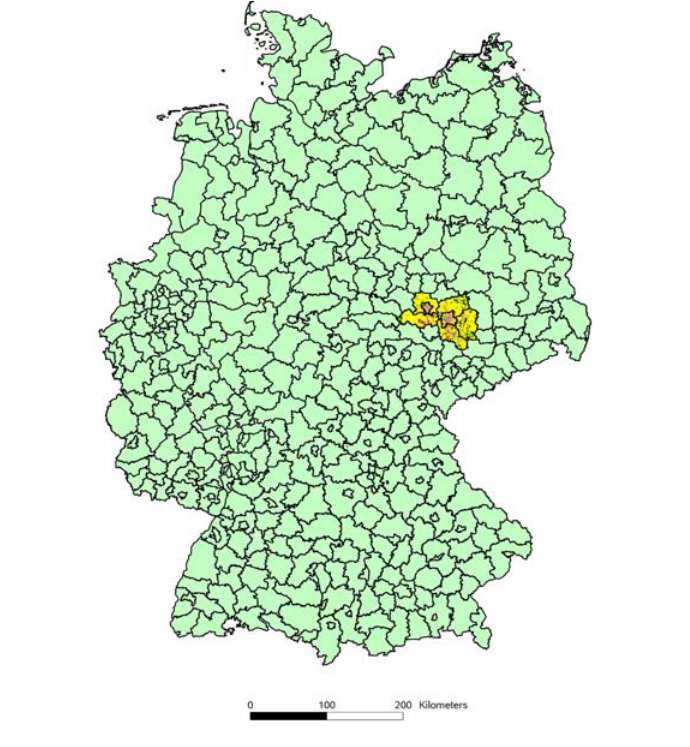
Figure 1: Location of the case study region Halle-Leipzig within Germany.